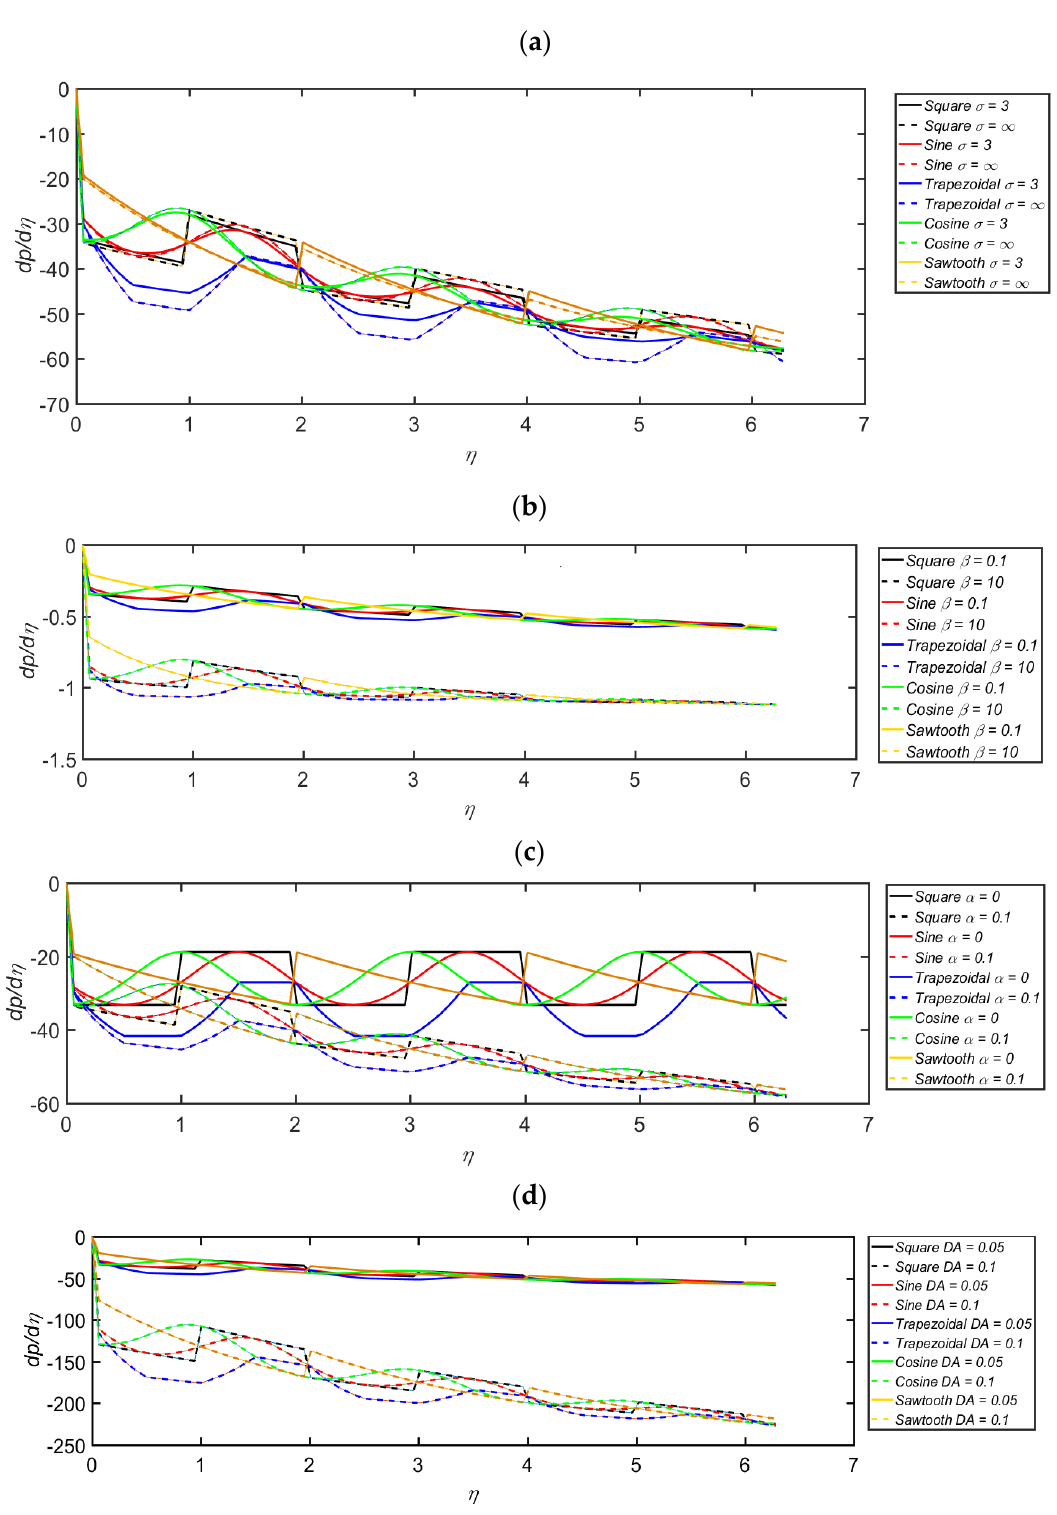
Figure 3. ( a ) The velocity distribution 𝑤(𝜍) for curvature parameter (𝜎) at 𝑞 = −3,𝐷𝐴 = 0.01,𝛼 = 0.1,𝛽 = 0.1,and 𝜙 = 0.2. ( b ) The velocity distribution 𝑤(𝜍) for viscoelastic parameter (𝛽) at 𝑞 = −3,𝐷𝐴 = 1,𝛼 = 0.1,𝜎 = 1.5,and 𝜙 = 0.2. ( c ) The velocity distribution 𝑤(𝜍) for non-uniform pa- rameter (𝛼) at 𝑞 = −3,𝐷𝐴 = 0.01,𝜎 = 1.5,𝛽 = 0.1,and 𝜙 = 0.2. ( d ) The velocity distribution 𝑤(𝜍) for porosity parameter (𝐷𝐴) at 𝑞 = −3,𝛽 = 0.1,𝛼 = 0.1,𝜎 = 1.5,and 𝜙 = 0.2.